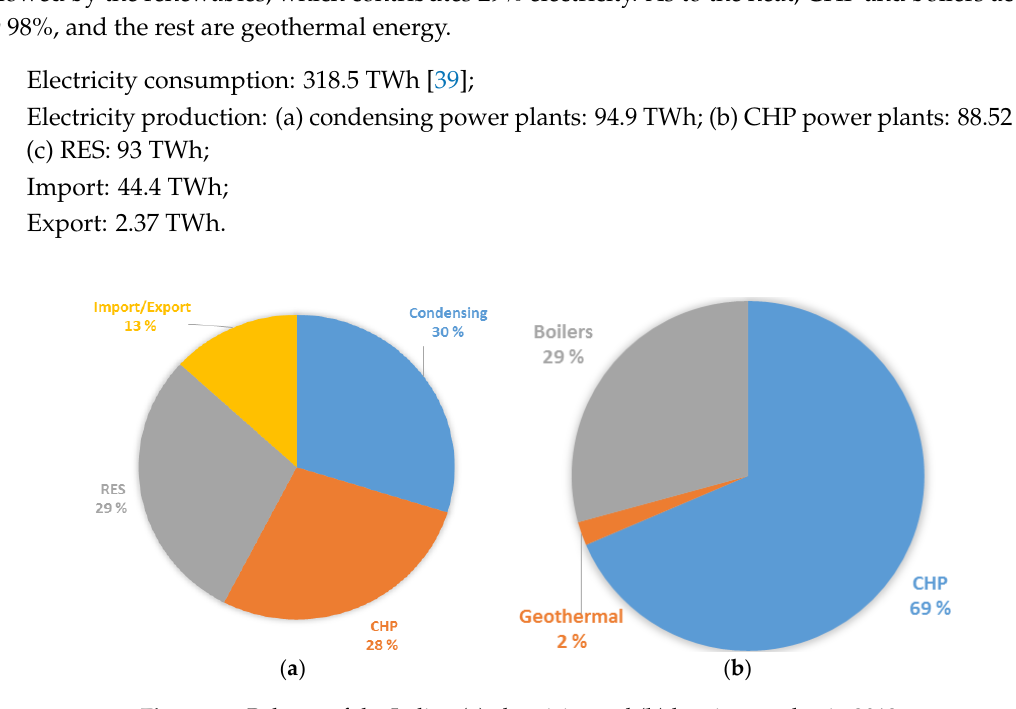
Figure 11. Balance of the Italian ( a ) electricity and ( b ) heating market in 2013.